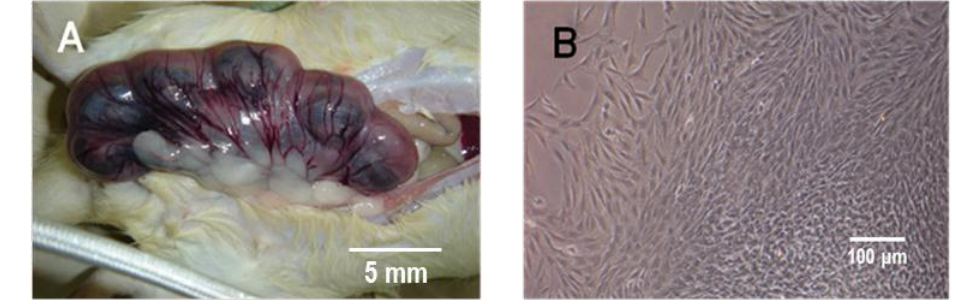
Figure 9. Odontogenic differentiation of GMSCs after two weeks of induction. ( A ) Representative images of embryonic Sprague-Dawley rats ; ( B ) Representative images of tooth germ cells (TGCs) . Representative cell cycle distribution graphs of GMSCs cultured with α-MEM ( C ) and ETGC-CM ( D ) for eight days ; and ( E ) The expression of odontogenic genes detected by